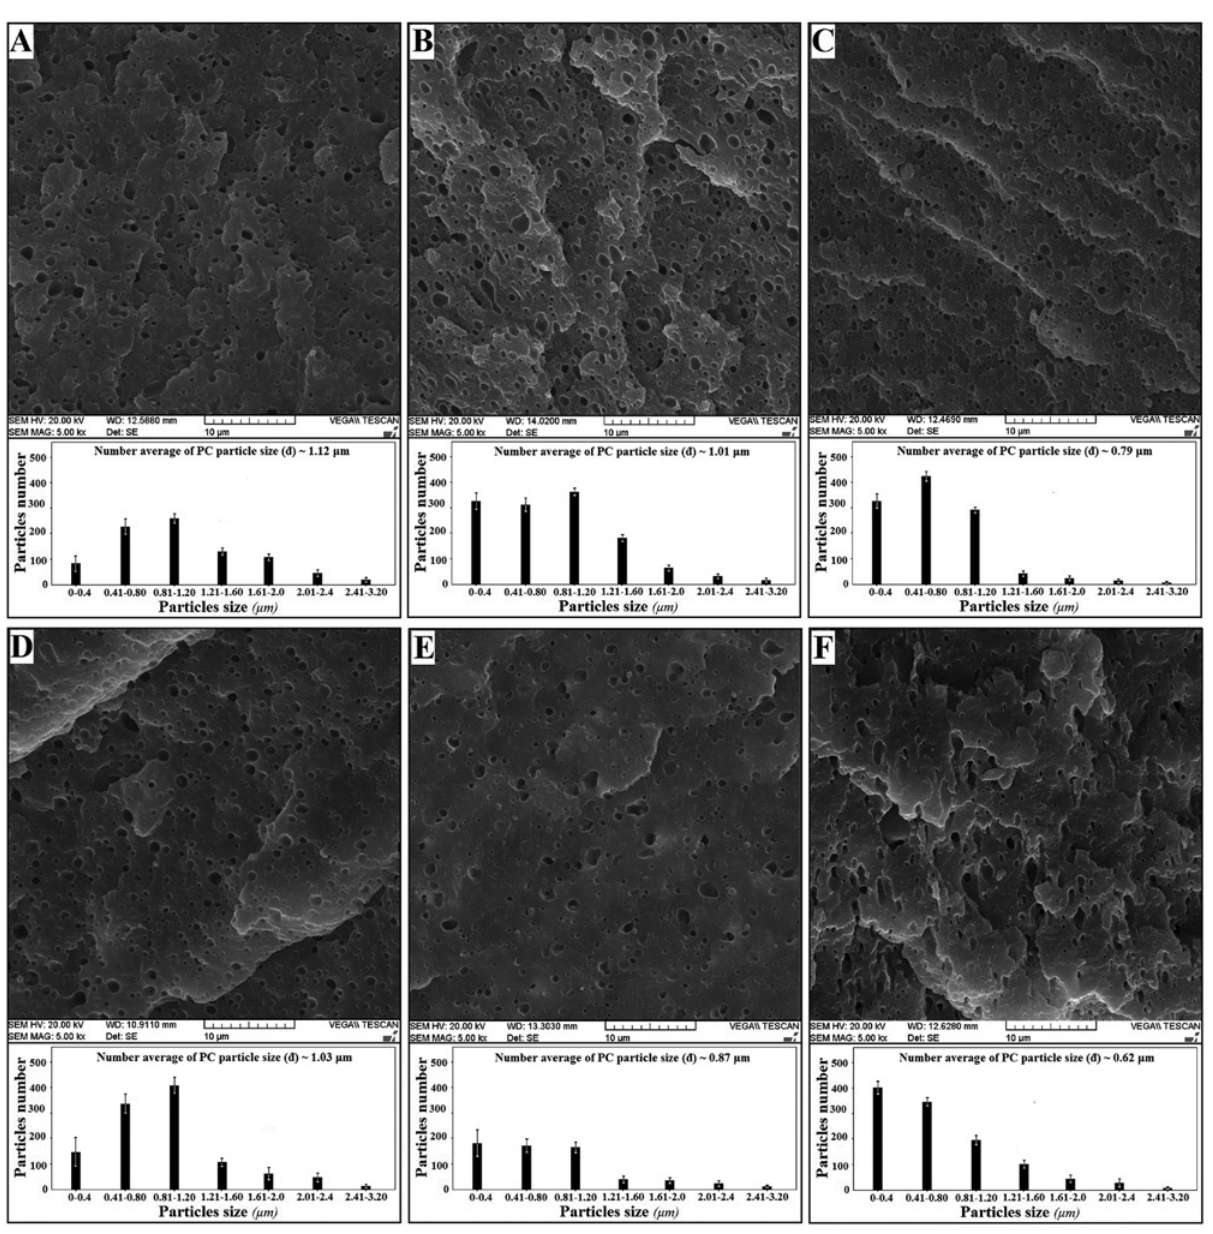
Figure 6: SEM images of fracture surfaces of (A) P1, (B) PN5, (C) PN7, (D) PG5, (E) PG7, and (F) PNG5 along with their the curves of respective particle size distributions. Figure 7 represented EDX micrographs of fracture surface of nanocomposites prepared with 3, 5, and 7 wt% of OC. As a confirmation that toluene did not affect the morphology, the SEM images of non-etched surface of PN3, PN5, and PN7 samples were done with EDX